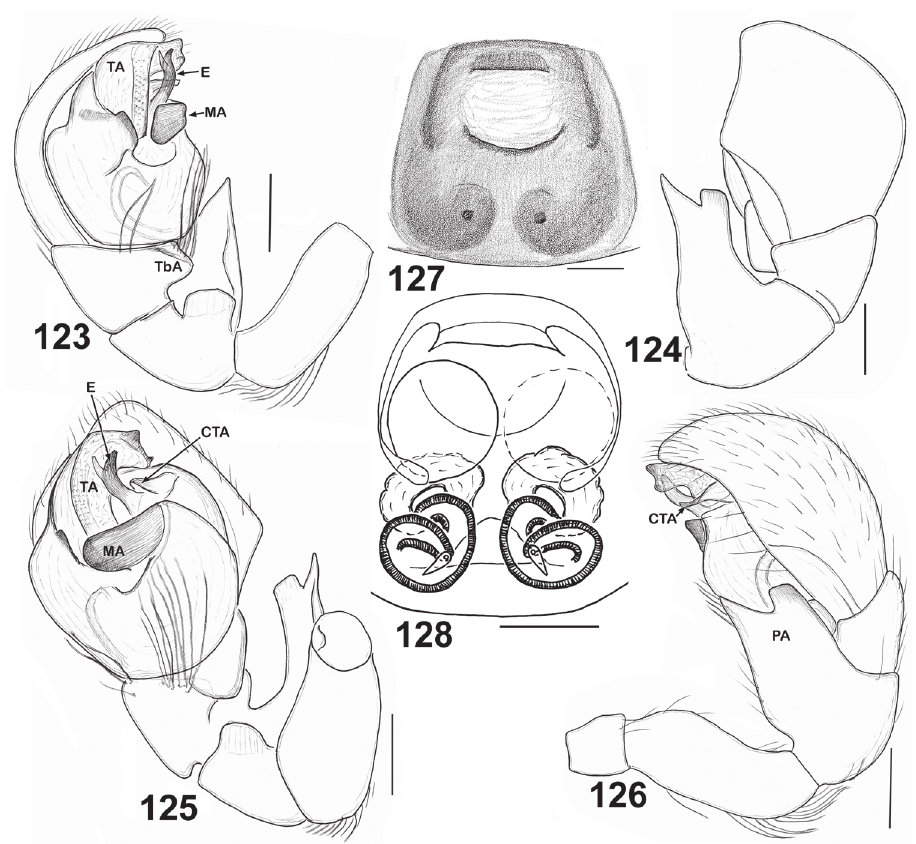
Figures 123–128. Copulatory organs of Eupoa yunnanensis from Laos. 123 male palp, median view 124 ditto, dorsal view 125 ditto, ventral view 126 ditto, retrolateral view 127 epigyne, verntral view 128 ditto, dorsal view. Abbreviations as explained in ‘Material and Methods’. Scale bars: 0.1 mm. FEMALE. Measurements . Carapace 1.13 long, 0.86 wide and 0.60 high at PLE. Ocu- lar area 0.59 long, 0.89 wide anteriorly and 0.76 wide posteriorly. Diameter of AME 0.29. Clypeus height 0.06, chelicera length 0.20. Abdomen 1.10 long, 0.85 wide. Length of leg segments: I: 0.65 + 0.28 + 0.48 + 0.40 + 0.25; II: 0.53 + 0.23 + 0.35 + 0.35 + 0.23; III: 0.51 + 0.23 + 0.38 + 0.40 + 0.25; IV: 0.90 + 0.33 + 0.73 + 0.50 + 0.30. Leg spination